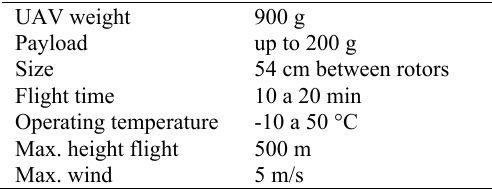
Table 2. Technical specifications of the Microdrone md4-200 platform.